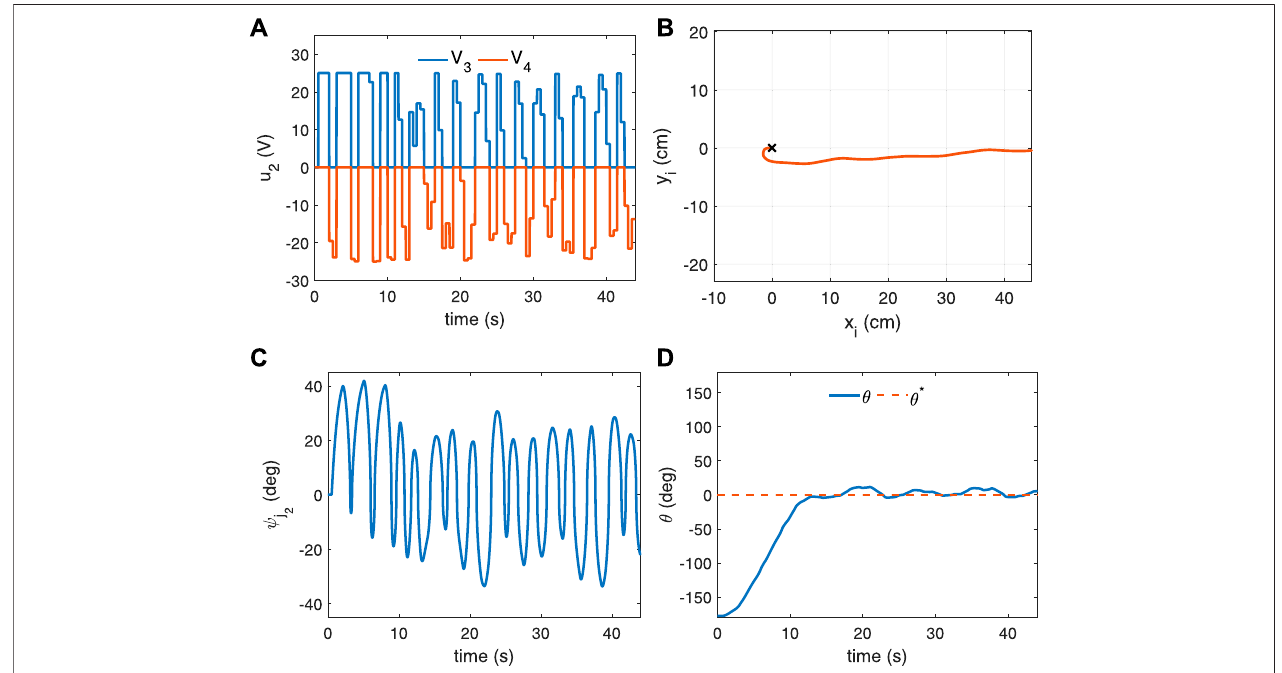
FIGURE7| Simulatedresultofyawcontroloftherobotic fi shinitializedattheoriginwithpose (x i ,y i , θ ) (cid:1) (0,0, − 178 ° )anddesiredorientation θ p (cid:1) 0 ° . (A) Controlinput u 2 representing the voltages of the SCP muscles m 3 , m 4 ; (B) the trajectory of the robotic fi sh turning from − 178 ° to 0 ° ; (C) the tail fl ap angle ψ j fi sh θ .